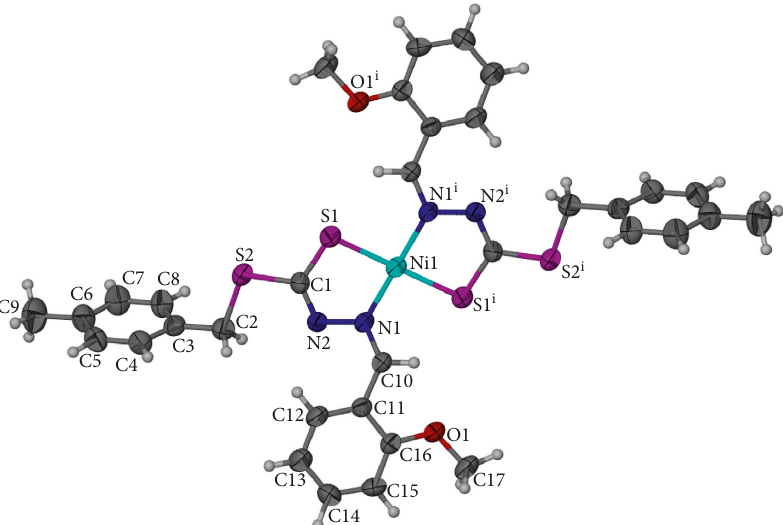
Figure 4: Structure of 3 with ellipsoids shown at 50% probability. Selected bond lengths [ ˚ A] and angles [ ° ]: Ni1-N1 � 1.889 (6); Ni1–S1 � 2.153 (8); Ni-N2 � 1.393 (8); N1-Ni1-N1i � 180; and S1-Ni1-S1i � 180. Symmetry element used: i � 2 − x , − y , 2 − z .